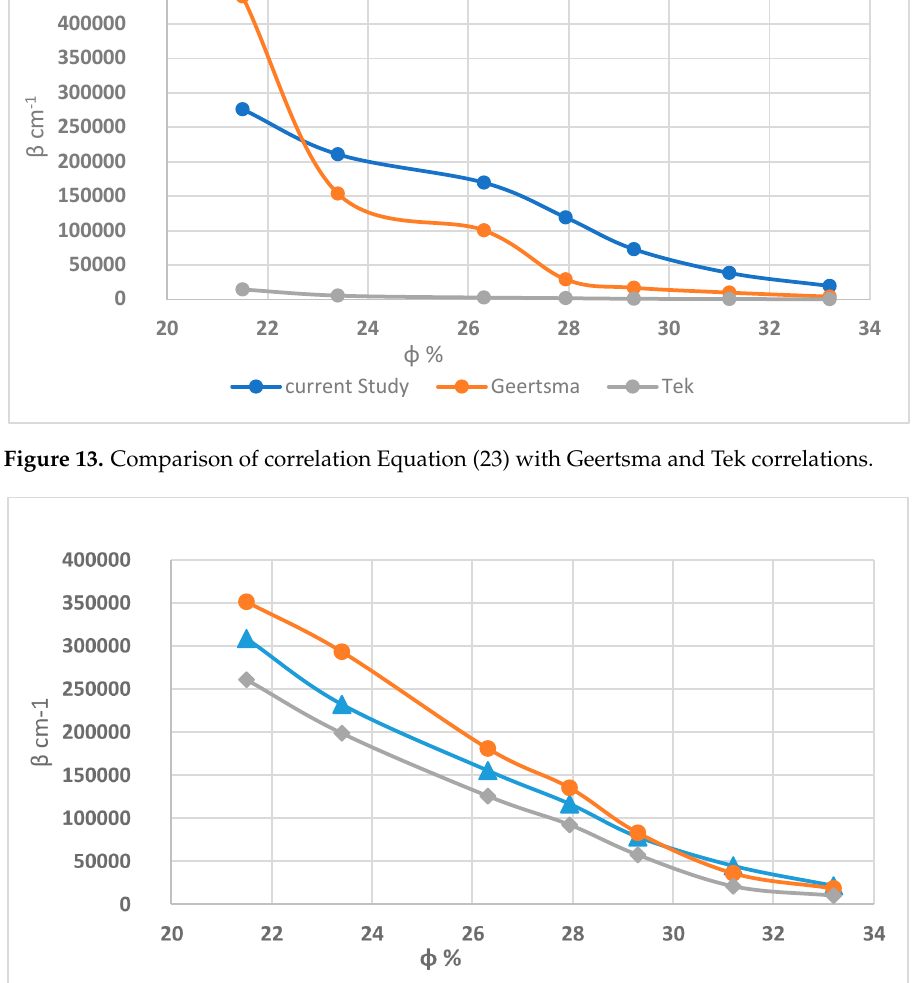
Figure 14. Comparison of correlation Equation (25) including tortuosity effect with Thauvin and Evans correlations.